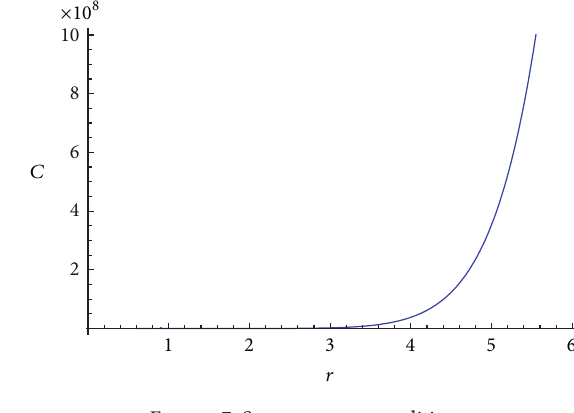
Figure 7: Strong energy